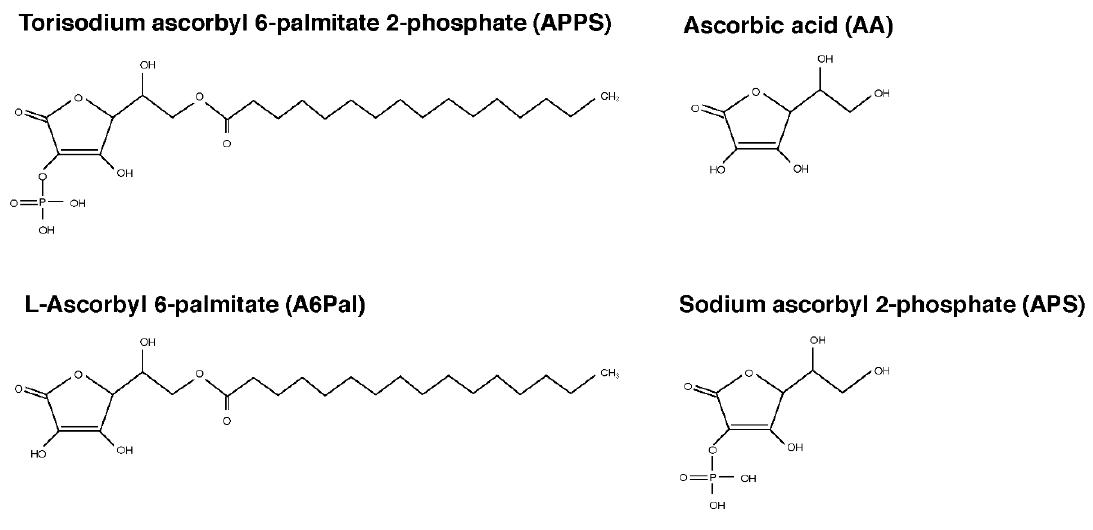
Figure 1. The structures of ascorbic acid (AA), A6Pal, APS, and APPS. L -ascorbyl 6-palmitate (A6Pal) is additionally conjugated with a long hydrophobic chain. Sodium ascorbyl 2-phosphate (APS) is additionally conjugated with a phosphate group. Torisodium ascorbyl 6-palmitate 2-phosphate (APPS) is additionally conjugated with a phosphate group and a long hydrophobic chain.